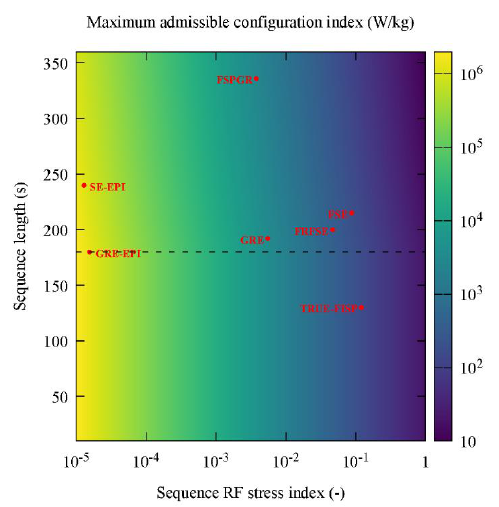
a sequence duration equal to T IEC /2. Below this value, ξ 10g,𝑆∗ becomes independent of the sequence duration.